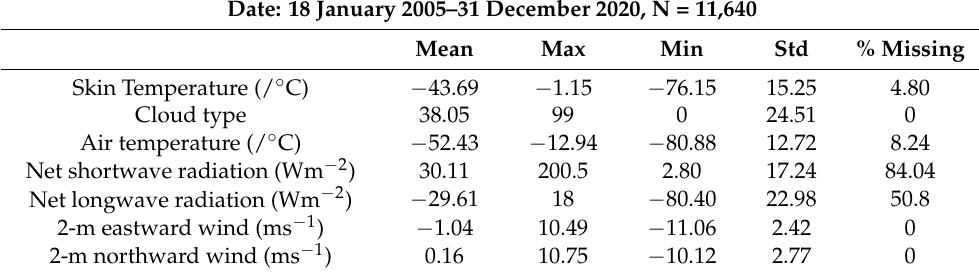
Table 1. Analysis of the multi-source data from 2005 to 2020.